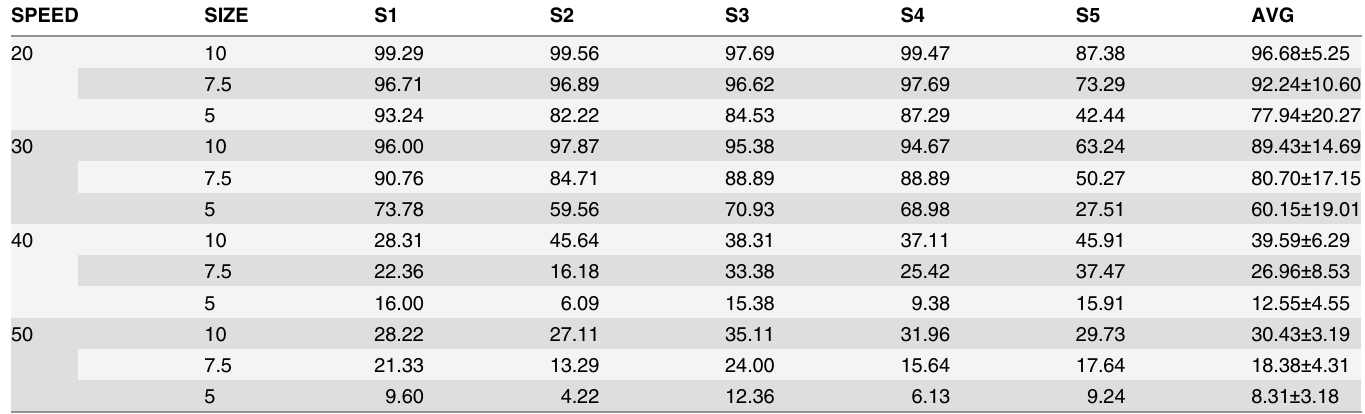
Table 1. Accuracy percentages (%) for different disc speeds (mm/s) and sizes (diameter in pixels).